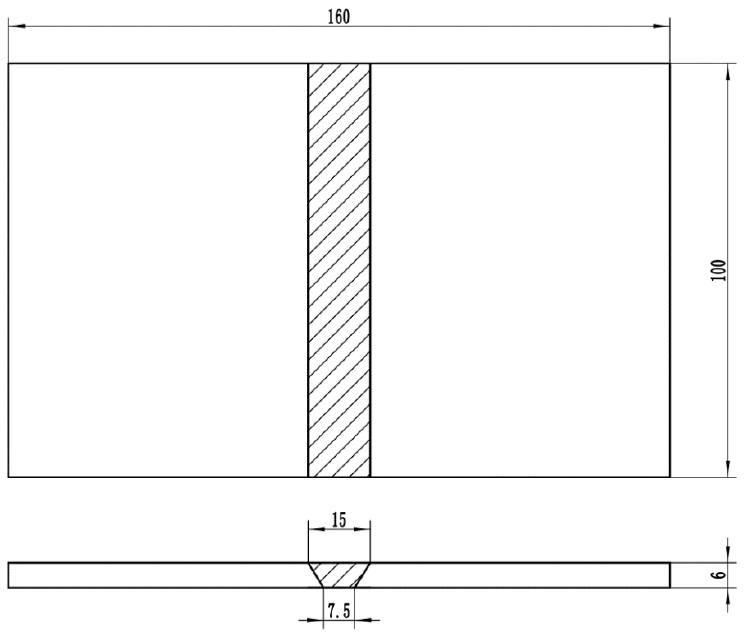
Figure 1. Schematic diagram of 2205 duplex stainless steel welded joint (mm).